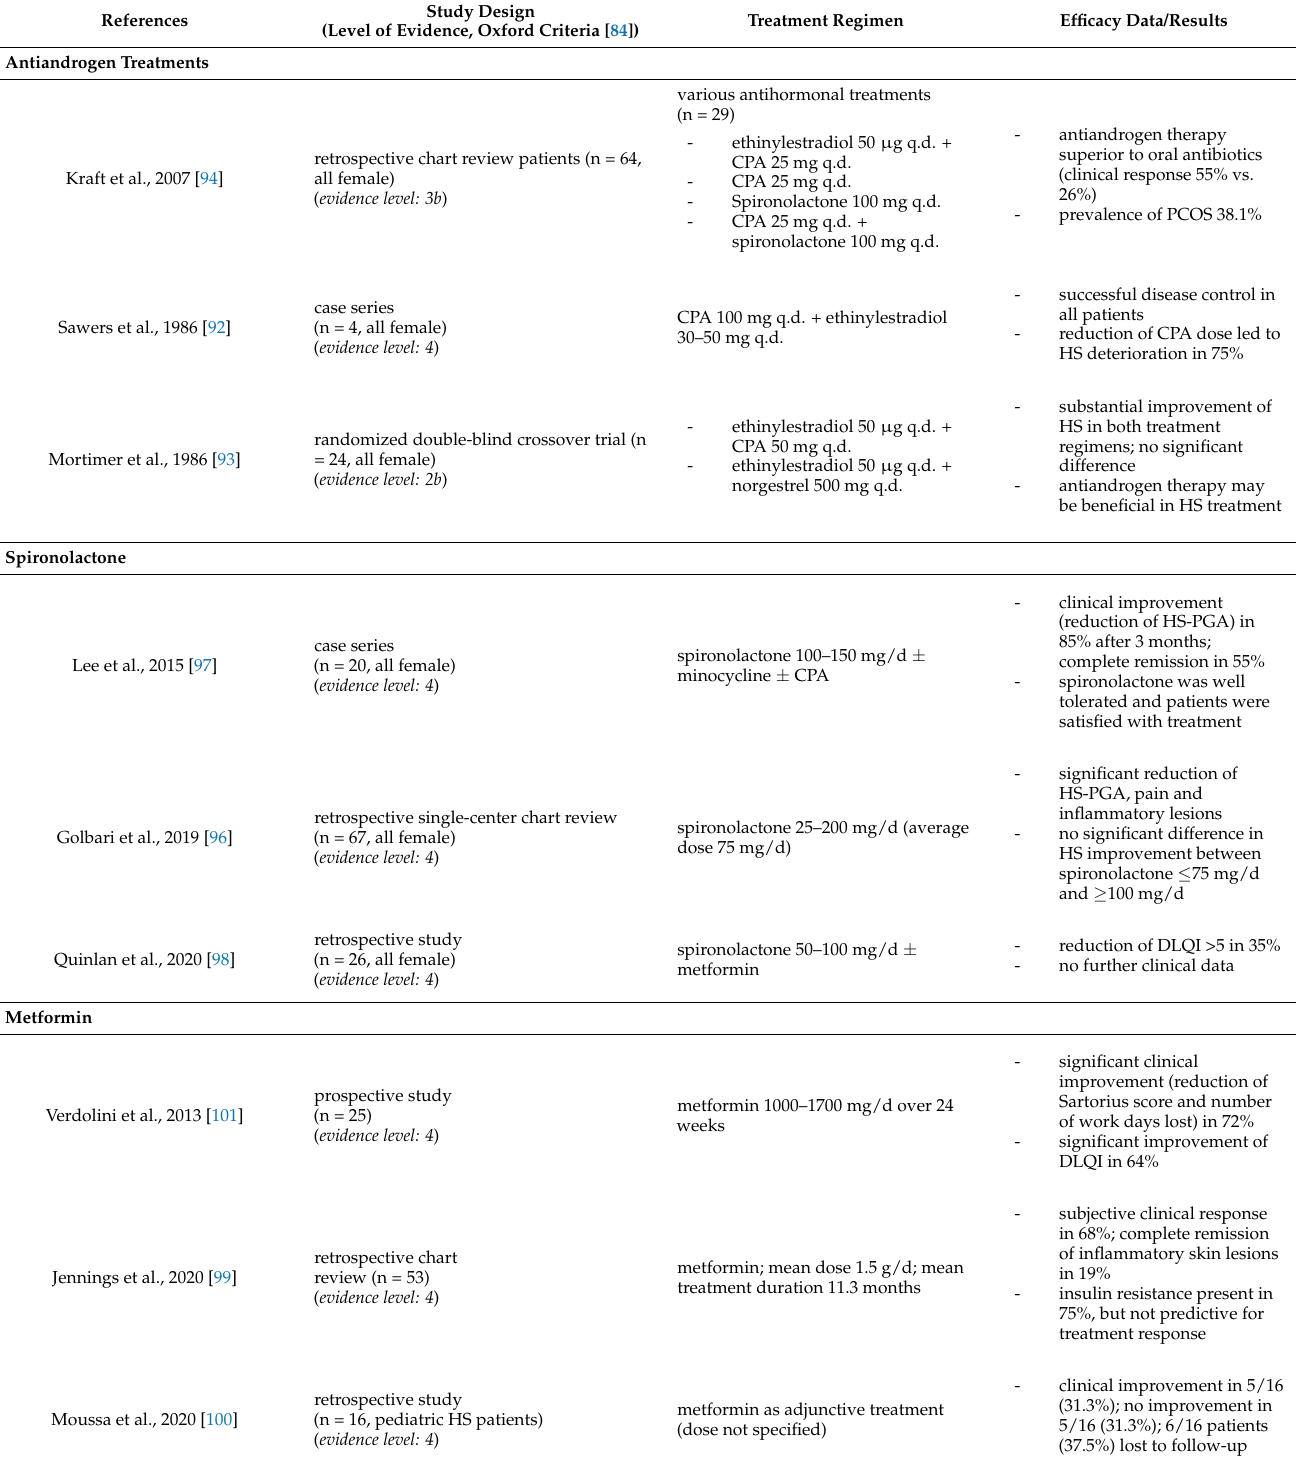
Table 2. Clinical studies evaluating hormonal treatment approaches in HS